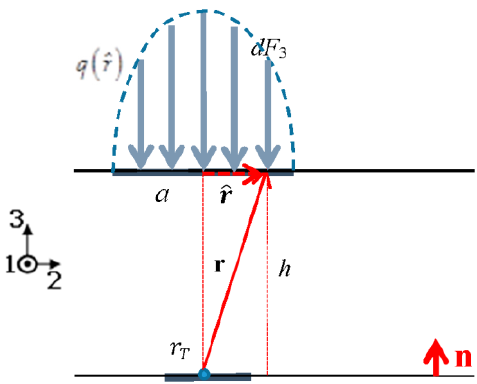
Figure 7. The extended PVDF sensor is located on the bottom of the elastic cover of thickness h and a distributed normal force applied on the outer surface is aligned with the sensor center.